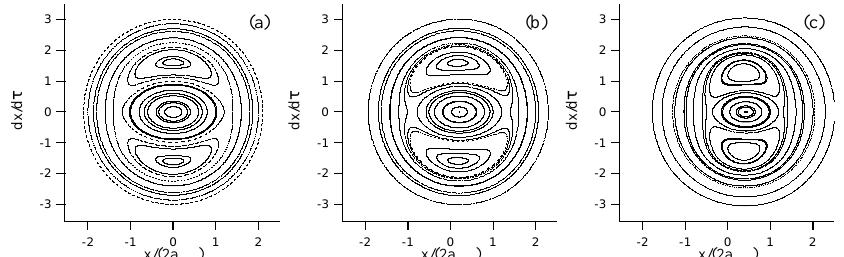
FIG. 4. The Poincaré surface of section plots for test particles in modest density cases. The test particle position scaled by the maximum beam boundary width 2 a max (cid:1) 2 a (cid:4) 0 (cid:5) is taken as the abscissa. Three different L , i.e., (a) L (cid:1) 0 , (b) L (cid:1) 2 , and (c) L (cid:1) 4 , are considered. Other parameters are fixed to h x (cid:1) 0.9 , M (cid:1) 0.13 , and j (cid:1) 0.15 . than the threshold L 0 , these particles become off the res-